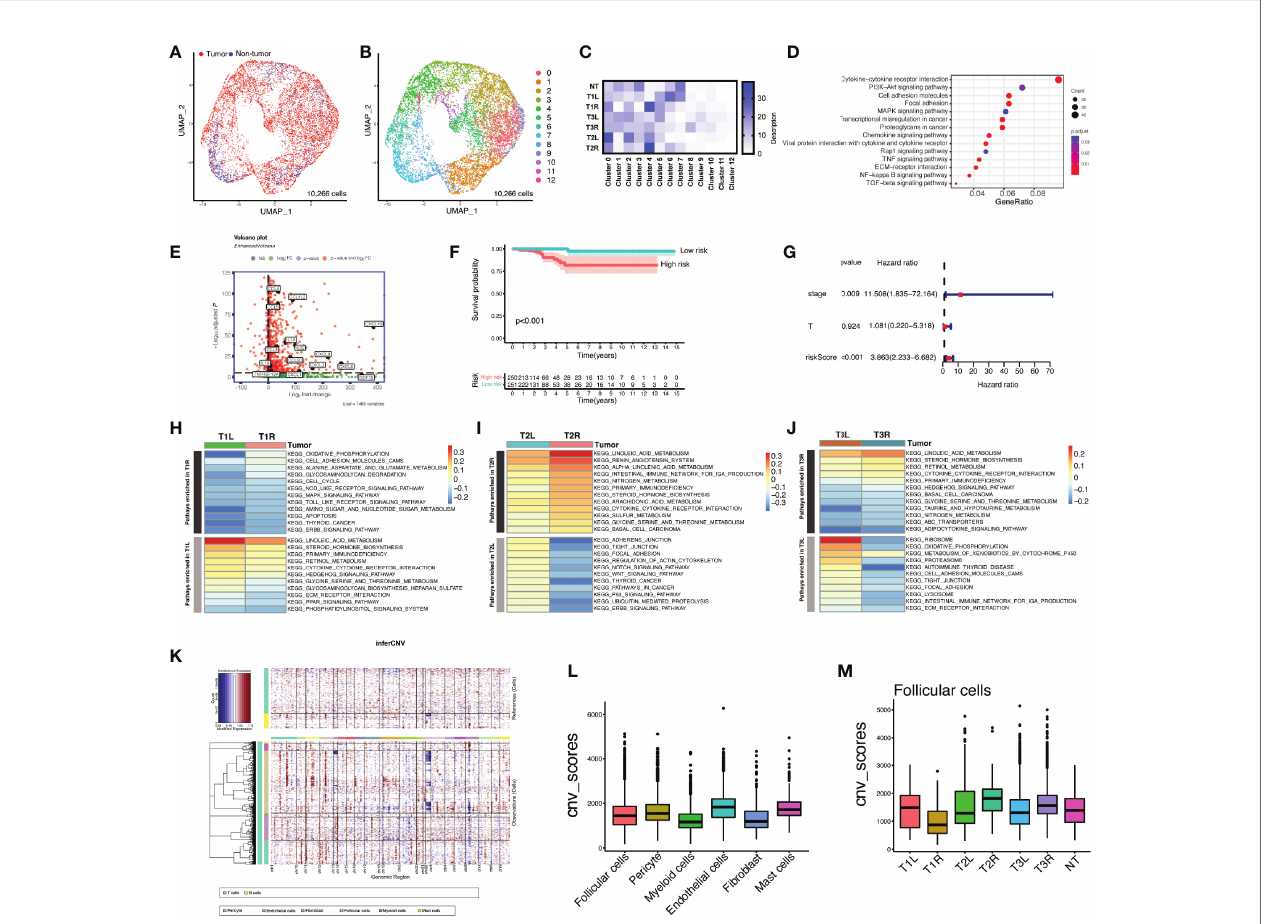
FIGURE 2 | Heterogeneity of the enriched pathways and copy number variation (CNV) in bilateral malignant thyroid follicular cells. (A) Uniform manifold approximation and projection (UMAP) plot of the classi fi cation of 10,266 malignant and non-malignant thyroid follicular cells. (B) UMAP plot of 13 clusters of thyroid follicular cells ( n = 10,266). (C) Heatmap of the proportions of 13 clusters in each sample. T1L and T1R : papillary thyroid carcinoma (PTC) from the left lobe and right lobe of patient P1, respectively. T2L and T2R : PTC from the left lobe and right lobe of patient P2, respectively. T3L and T3R : PTC from the left lobe and right lobe of patient P3, respectively. (D) Dot plot showing Kyoto Encyclopedia of Genes and Genomes (KEGG) pathways enriched in malignant thyroid follicular cells compared with non-malignant cells. (E) Volcano plot depicting the representation of overexpressed signature genes of the cytokine – cytokine receptor interaction pathway in malignant thyroid follicular cells. (F) Prognostic value of the risk score calculated based on signature genes of the cytokine – cytokine receptor interaction pathway in The Cancer Genome Atlas (TCGA) cohort of patients with papillary thyroid carcinoma. (G) Kaplan – Meier curve of the overall survival of patients from TCGA PTC cohort grouped by low and high risk scores of the 6-gene signature. (H – J) Gene set variation analysis (GSVA) showing great heterogeneity of the enriched pathways in bilateral thyroid cancer samples from the same patient. (K) Heatmap of the CNV pro fi les of all cell subtypes of patients with bilateral PTC. Red indicates genomic copy number gains and blue indicates copy number losses. The x -axis shows all chromosomes, while the y -axis is marked by cell subtypes within the tumor microenvironment. (L) Comparison of the CNV scores among different cell subtypes. (M) Comparison of the CNV scores in follicular cells of each